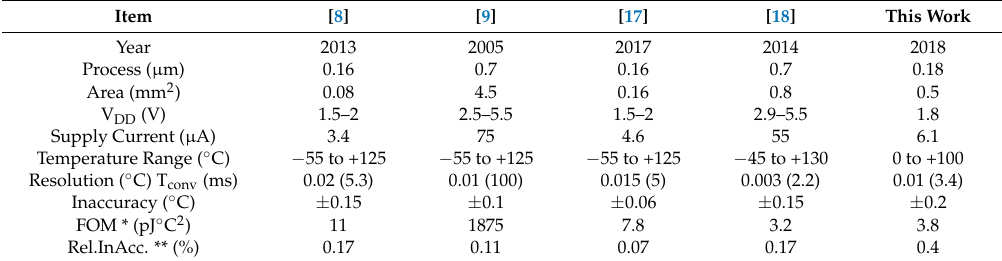
Table 1. Performance Comparison with Previously Reported Temperature Sensor